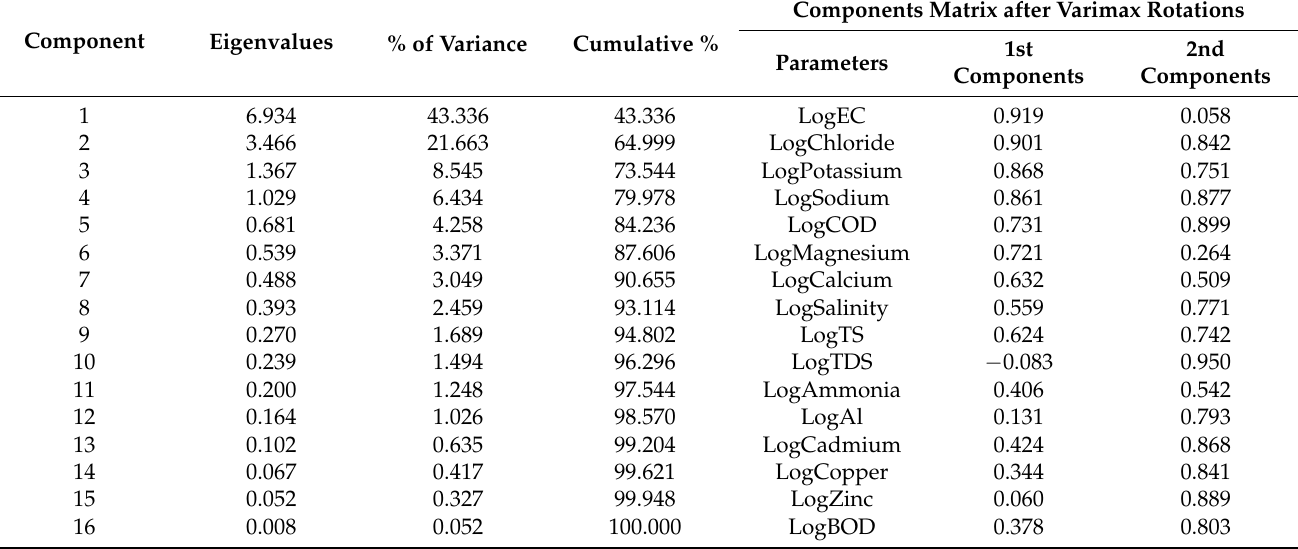
Table 6. The values of total variance and rotated components matrix for final analysis.